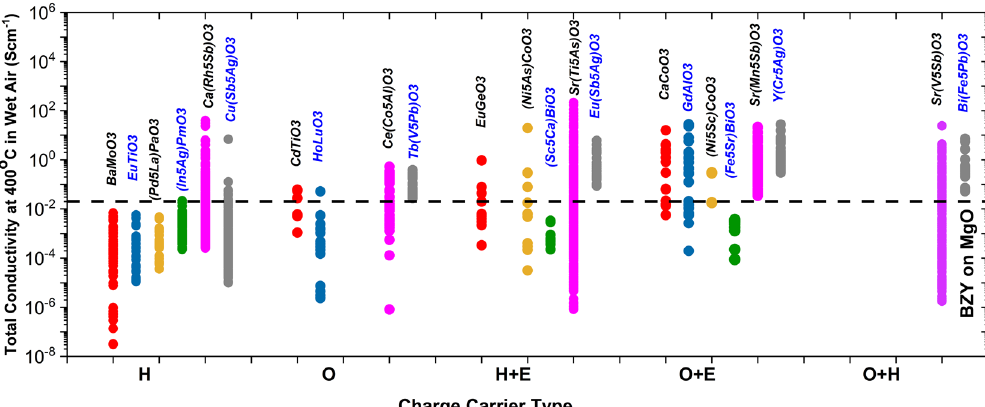
Fig. 6 Summary of all the screened stable perovskites of different charge carriers. Different colored symbols indicate different classes of perovskites: red solid symbols are pure type I (AO + BO 2 ) perovskites, blue are type II (A 2 O 3 + B 2 O 3 ) perovskites, yellow are the A-site doped type I perovskites, green are A-site doped type II, purple are the B-site doped type I, and gray are the B-site doped type II perovskites. Type I are doped with M 2 O 3 and type II are doped with MO type oxides. The top candidate for each class has been labeled. The conductivity of BZY at 400 °C is shown by a black line for